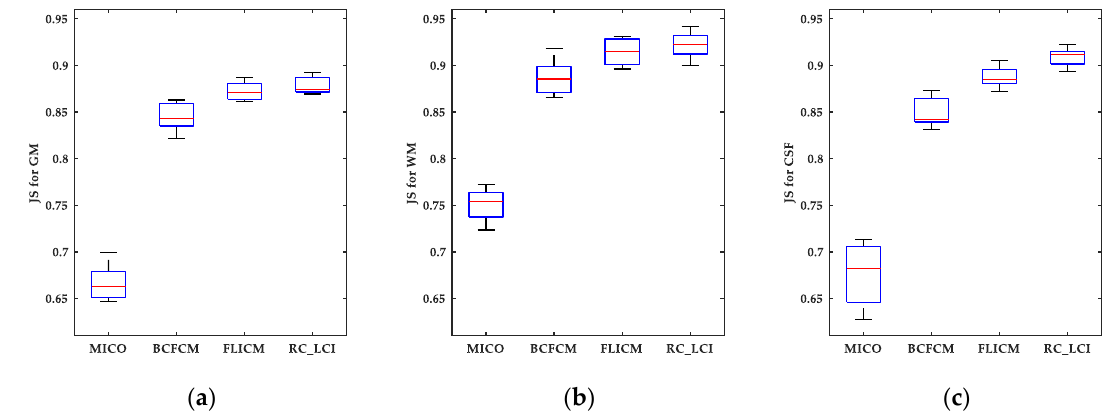
Figure 4. Jaccard similarity coefficients of MICO, BCFCM, FLICM, and RC_LCI: ( a ) Jaccard similarity (JS) for gray matter (GM); ( b ) JS for white matter (WM); and ( c ) JS for cerebrospinal fluid (CSF).